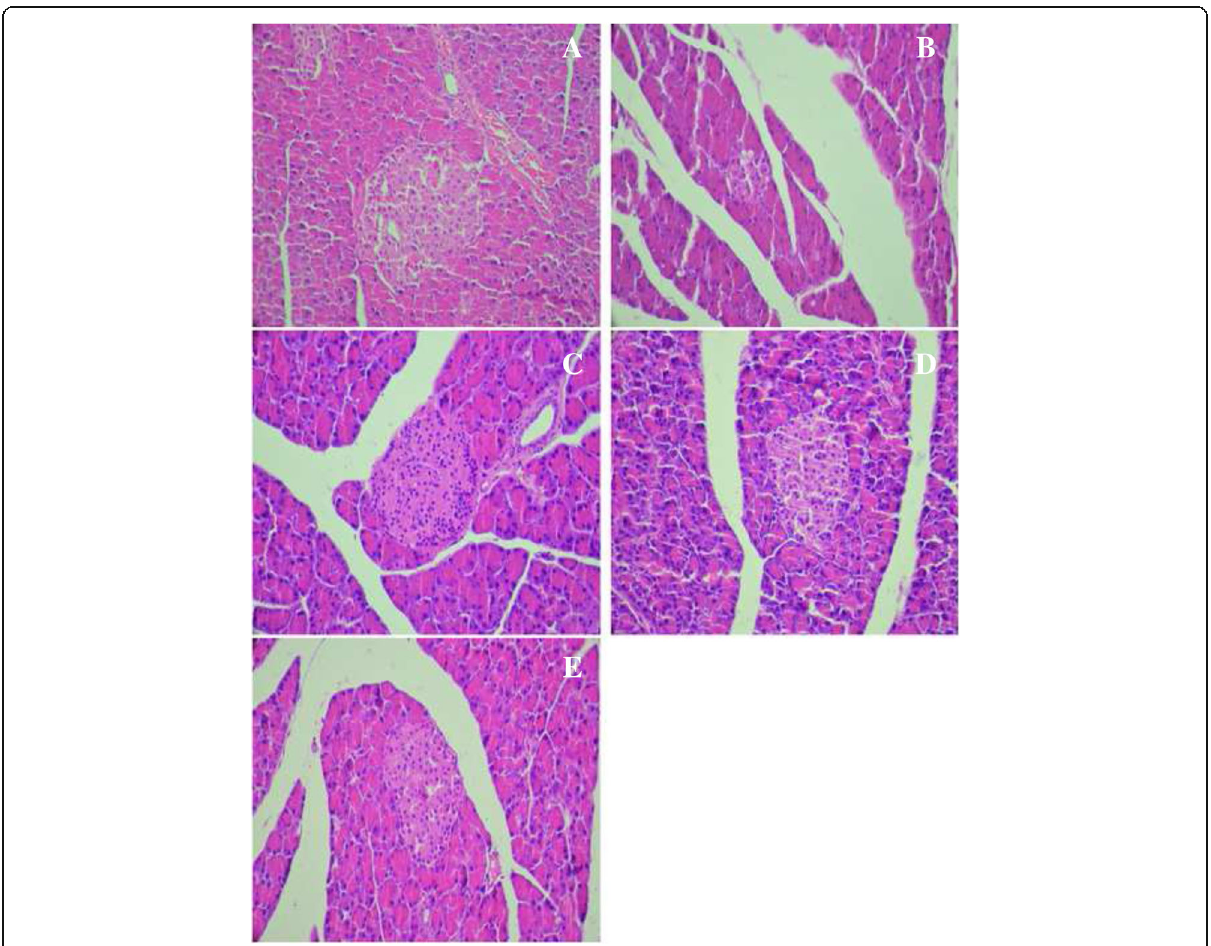
Fig. 9 Histopathological studies of pancreas in experimental groups of rats. a Section of the pancreas from a control rats showing normal β -cells of pancreas; ( b ) alloxan-diabetic rat a moderate β -cells atrophy; ( c-d ) alloxan-diabetic rat treated with the ethanol extract from leaves of C. scolymus at a doses of (200 mg/kg-400 mg/kg) and ( e ); alloxan-diabetic rat treated with acarbose, a partial protective action was shown (H&E ×